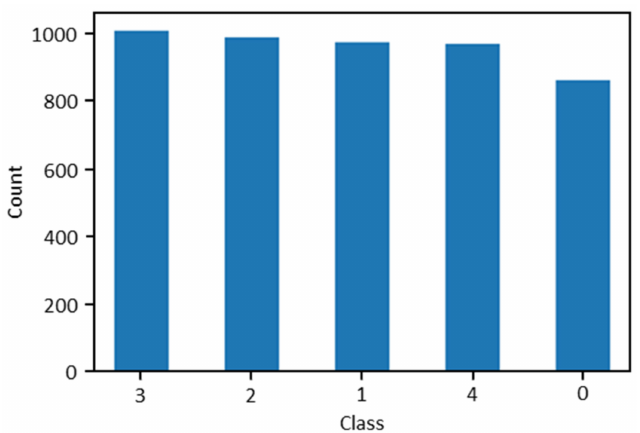
Figure 3. Bar chart showing counts of each class; labels 0–4 correspond to “fist” (0), “flat” (1), “okay” (2), “rock” (3), and “victory” (4) hand